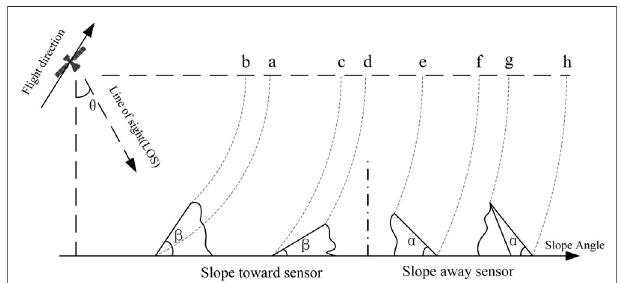
FIGURE 4 | Geometric distortion diagram of radar side-view imaging. When illuminated towards the satellite, foreshortening (C – D) occurs when the slope angle is less than or equal to, and layover (B – A) occurs when the slope angle is greater than. When backward facing the satellite, shadowing (G – H) occurs when the slope angle is greater.